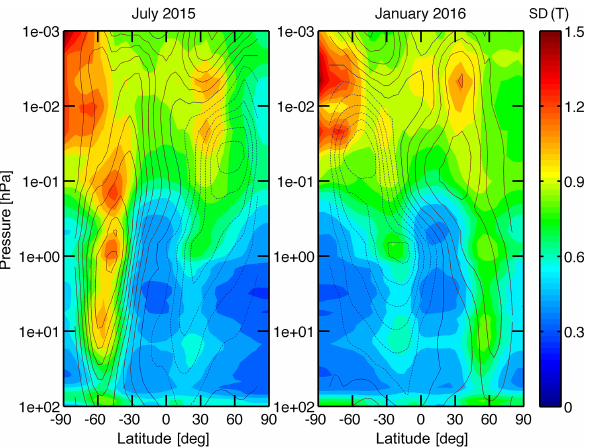
Figure 3. Monthly zonal mean of temperature (upper panel) and its standard deviation (SD( T ), lower panel) for January 2016 as ob- served by the satellite experiment Aura/MLS. Compared to the win- ter Southern Hemisphere in Fig. 2, the winter Northern Hemisphere shows larger stratospheric temperature variations, which are mainly due to planetary Rossby waves and the deformation and displace- ment of the stratospheric polar vortex.